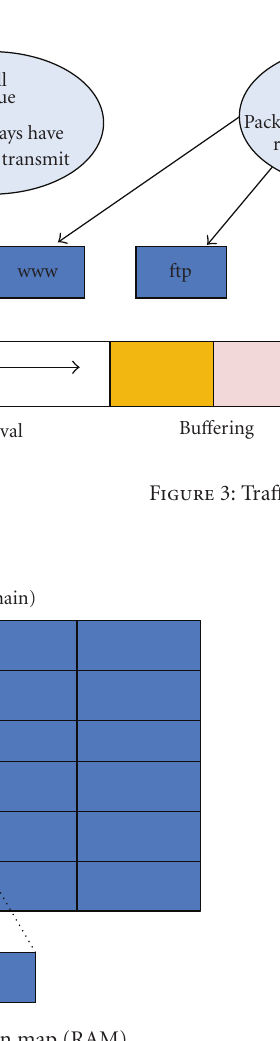
Figure 4: Resource allocation map (RAM).